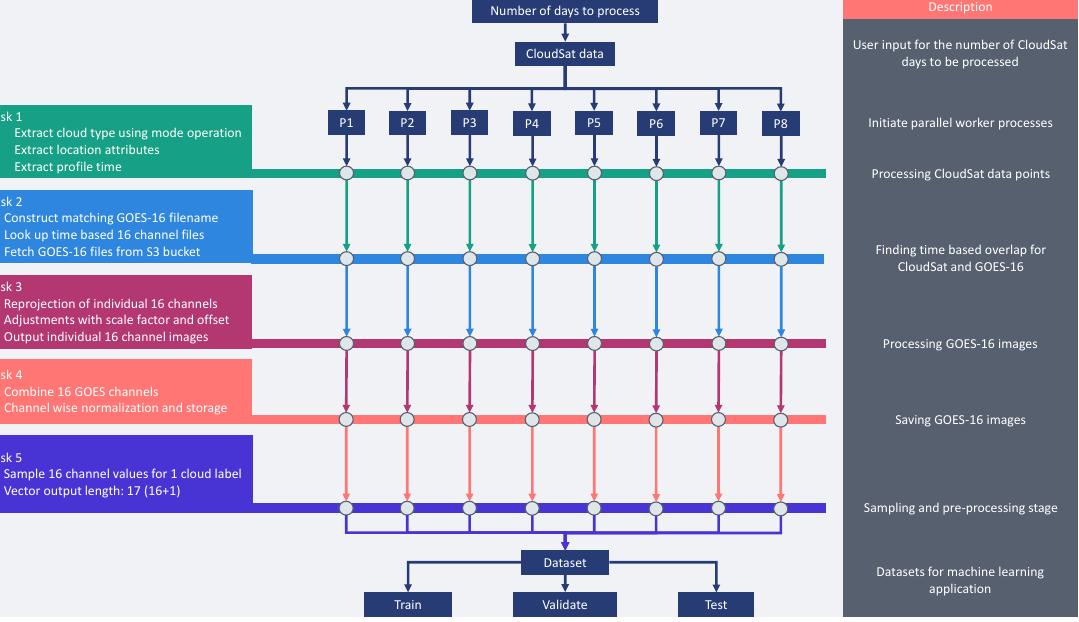
Figure 2. A schematic for automated data generation